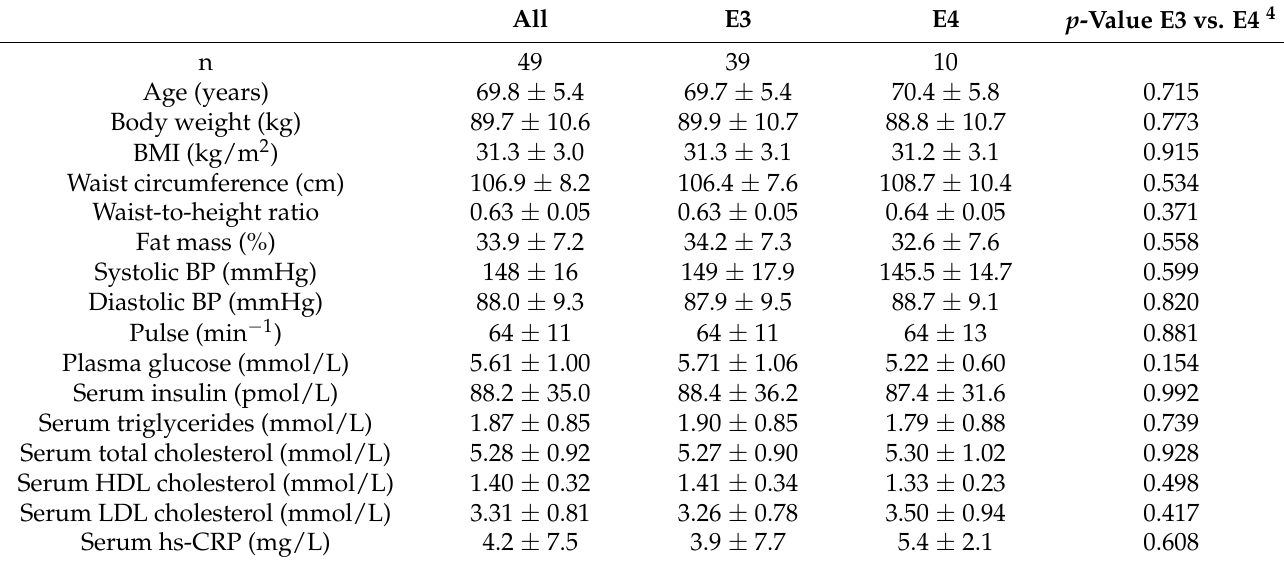
Table 2. Baseline characteristics of the participants according to the APOE genotype 1 − 3